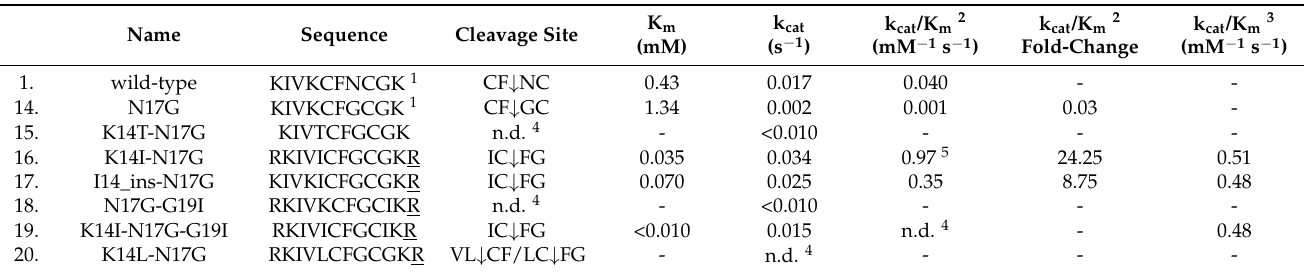
Table 3. Proteolytic processing of oligopeptides representing “revertant” mutants of the proximal cleavage site in the HIV-1 NC. The table shows the multiply substituted cleavage site peptides. Modified positions are highlighted with a grey background, the terminal residues added to increase peptide solubility are underlined. The values for wild-type and N17G from Table 2 are also shown here for better comparison, as